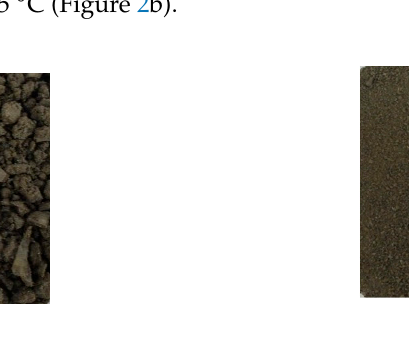
Figure 2. Raw ( a ) and dried ( b ) PET bottle washing waste (PETWW).